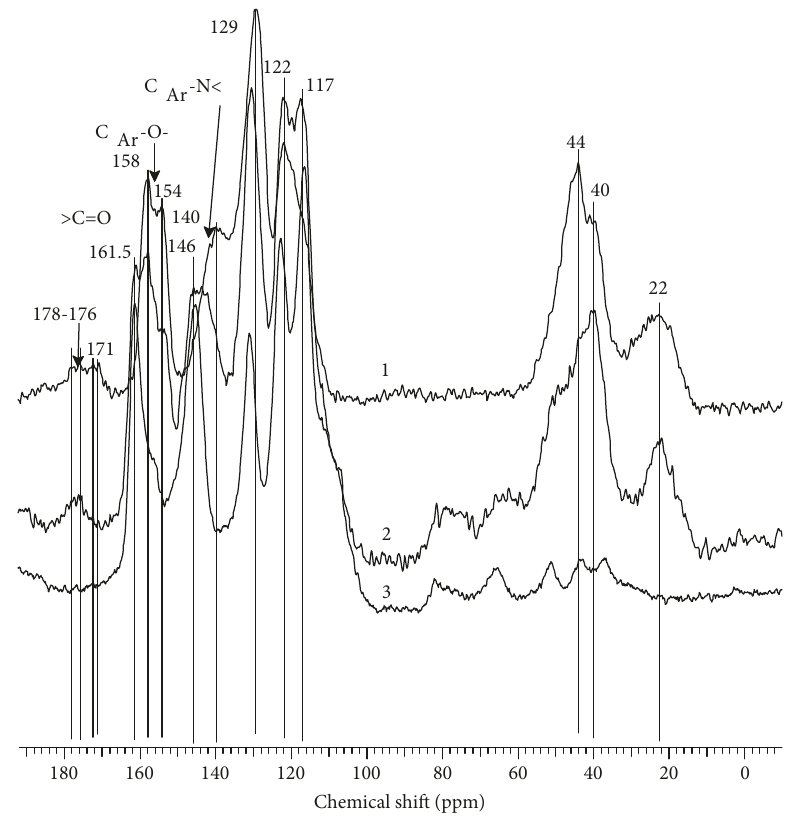
Figure 8: 13 С NMR spectra of the samples of ROL-II- (50 wt.%) 1,3-BAPB (50 wt.%) (XIII) blends (1), ROL-II (100%) (2), and the 1,3-BAPB = 320 ° C sample oligomerized in the regime with T fin cur